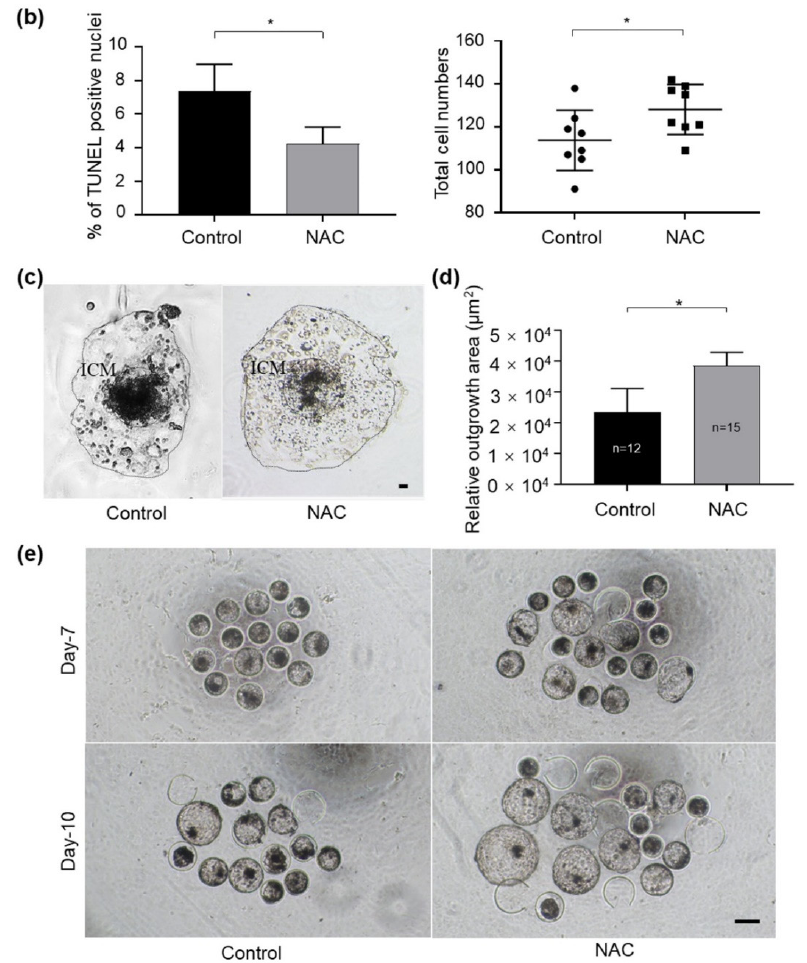
Figure 4. Supplementation of NAC to the culture medium in bovine embryo development. ( a ) Apoptotic cells in blastocysts treated with 1 mM NAC during 3–6 dpf were stained in a TUNEL assay. Nuclear DNA is shown in blue; apoptotic blastomeres are shown in green. Scale bars = 100 µ m. ( b ) The apoptotic rate and total cell number were quantified from the fluorescent images with ImageJ software. ( c ) Representative images of the morphology of blastocyst outgrowth on 14 dpf. ( d ) The trophoblastic spreading area was quantified using the ImageJ software. ( e ) Photos taken on 7 dpf and 10 dpf in the presence of NAC during culture. NAC, N-acetyl-L-cysteine; dpf, day post fertilization; ICM, inner cell mass. Values are means ± SEM calculated from three replicates; *, p <